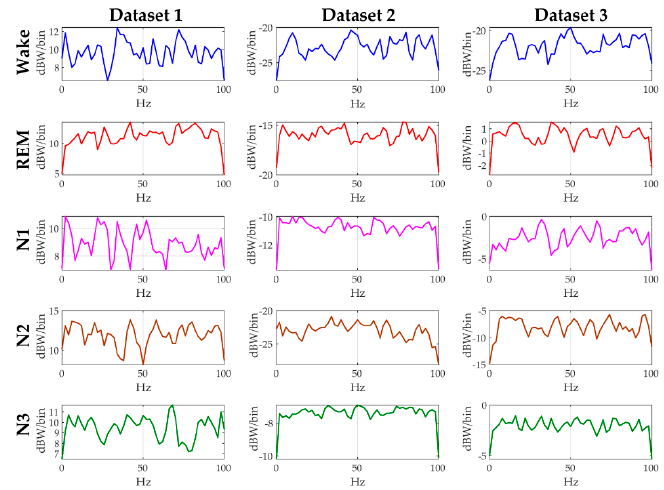
Figure 2. Power spectral density (PSD) curves of all the sleep stages of a single female subject but from different datasets.